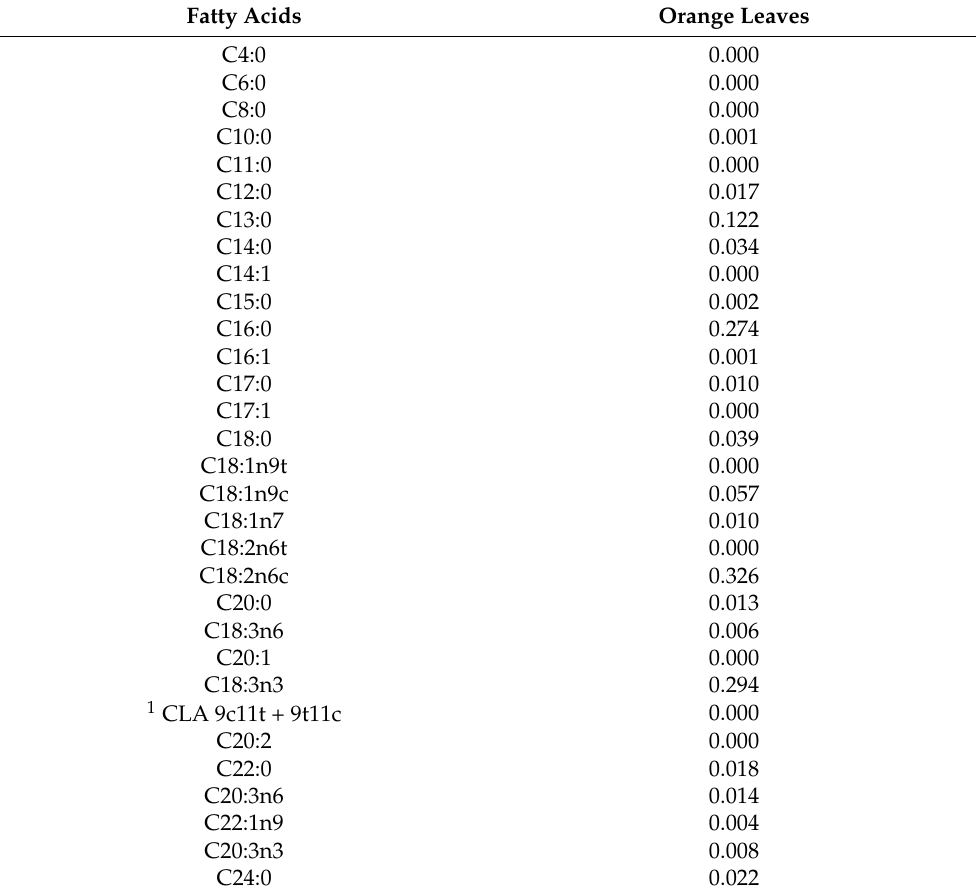
Table 3. Fatty acid profile from orange leaves (mg/100